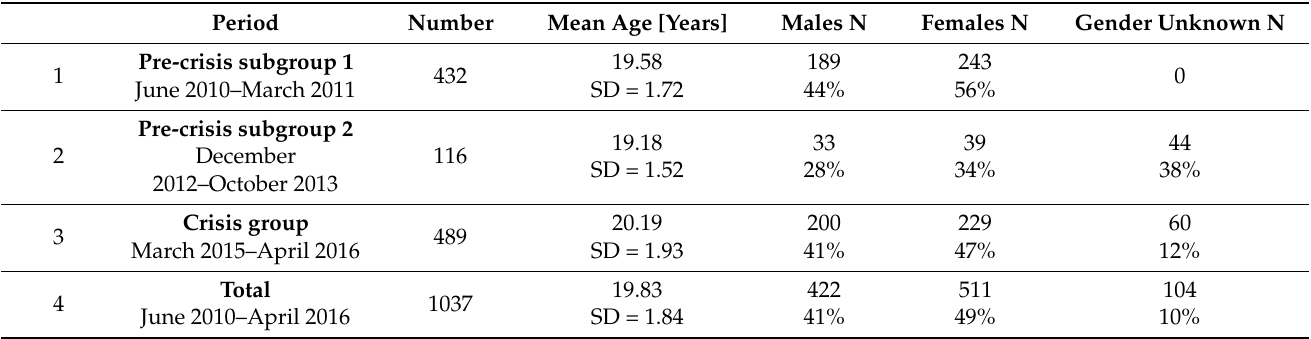
Table 1. Characteristics of the western (Lviv) region sample based on age, sex, and time of data collection.